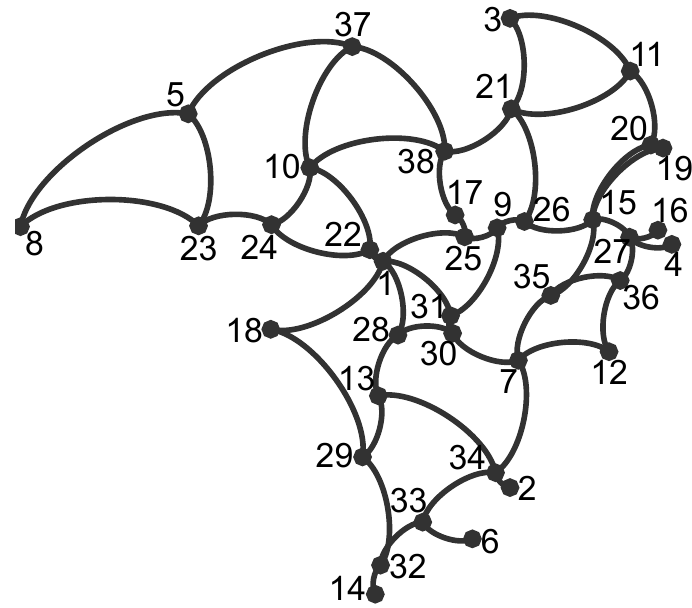
Figure 3. Graph representing the Nampula